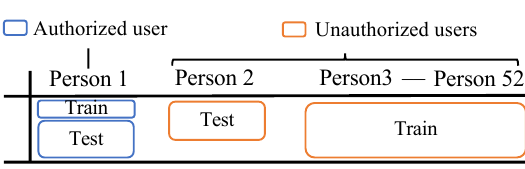
Figure 7. An example of splitting training data and test